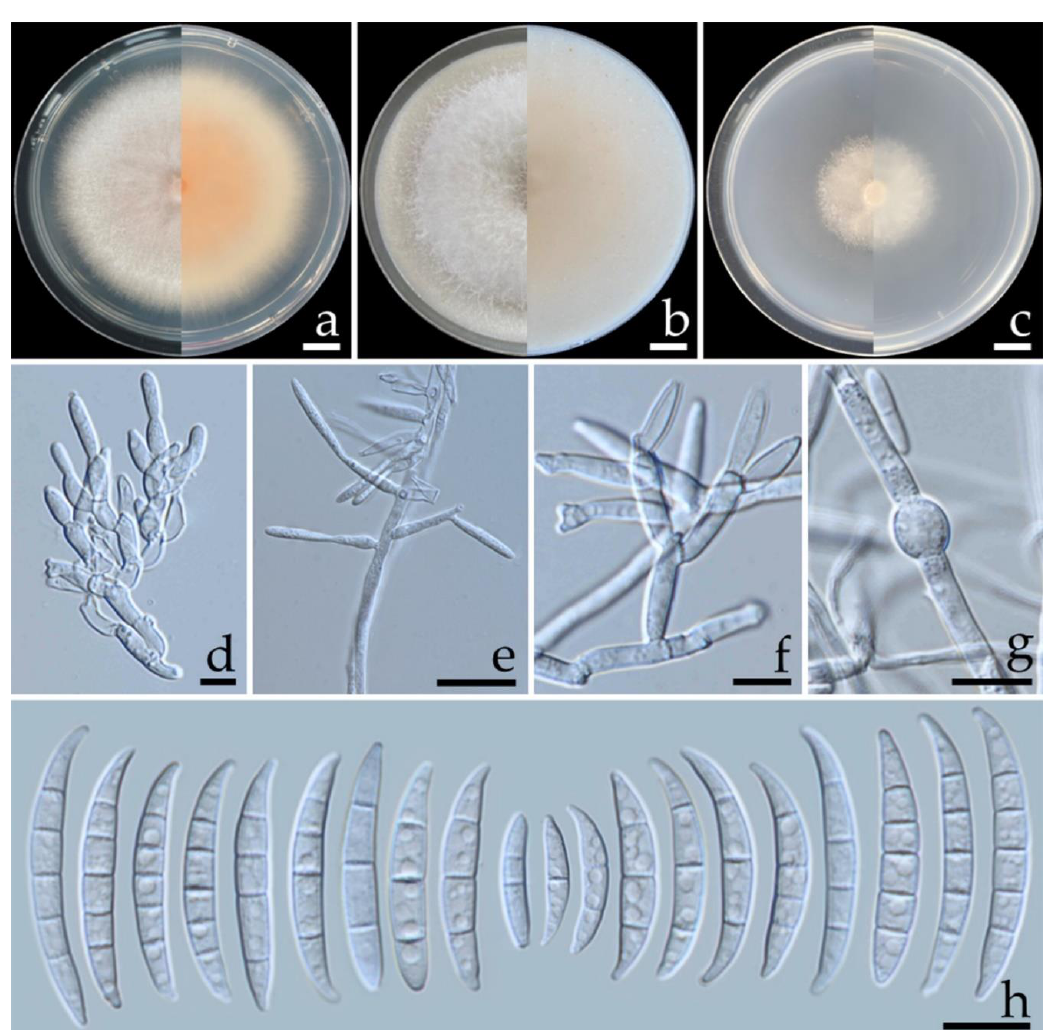
Figure 3. Fusarium citrullicola (SDBR-CMUS422; holotype). Colonies incubated at 25 °C for one week on PDA ( a ), OA ( b ), and SNA ( c ) (left, surface view and right, reverse view). Conidiophores on aerial mycelium ( d ). Lateral monophialides on aerial mycelium ( e ). Polyphialides on aerial mycelium ( f ). Chlamydospores ( g ). Aerial conidia ( h ). Scale bars: ( a – c ) = 10 mm; ( d – h ) = 10 µ m. Description: Colonies on PDA, OA, and SNA were described at 25 °C after seven days of incubation. Colonies on PDA grew to 68.0 − 74.5 mm in diameter, slightly raised, aerial mycelia dense, colony margin entire, orange white (6A2) in the center, white at the margin; reverse light orange (6A5) in the center, white at the margin. Colonies on OA reached 75.0 – 85.0 mm in diameter, umbilicate, aerial mycelia dense, colony margin entire, surface white; reverse pale orange (5A3) in the center, white at the margin. Colonies on SNA attained a diameter of 45.5 – 51.0 mm, flat, aerial mycelia scant, colony margin entire, surface white; reverse white. Pigment and odor absent. No sporodochia were observed in all agar media. Conidiophores borne on aerial mycelium, 10–120 × 1.8–3.2 µ